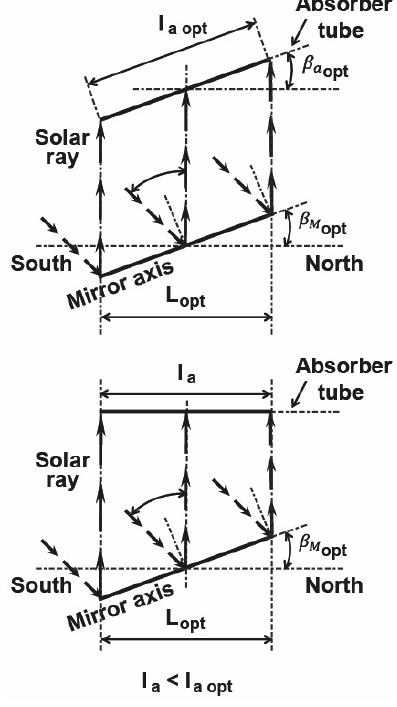
Figure 3. Influence of β a